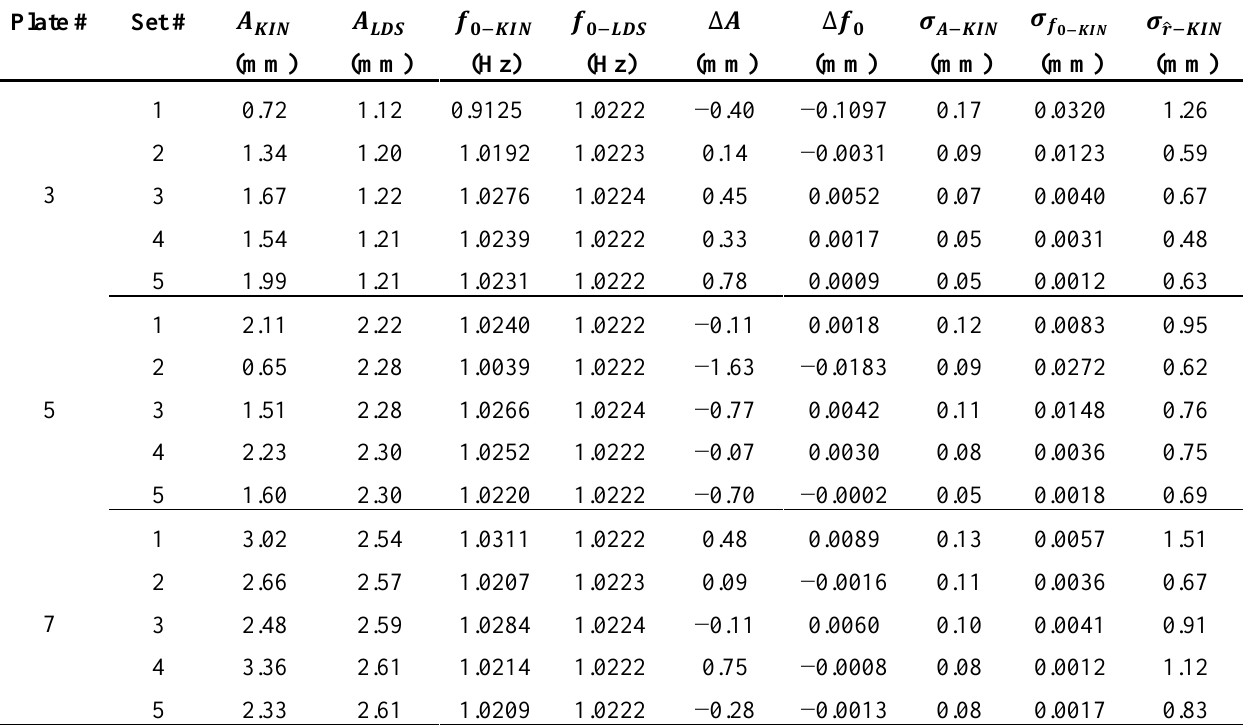
Table 1. Recovered loading frequencies and amplitudes for Plates 3, 5 and 7 ( = 1 Hz). , , , and are the amplitude, loading frequency and their corresponding standard deviations estimated from the Kinect data; , , and are the amplitude, loading frequency and their corresponding standard deviations estimated from the LDS